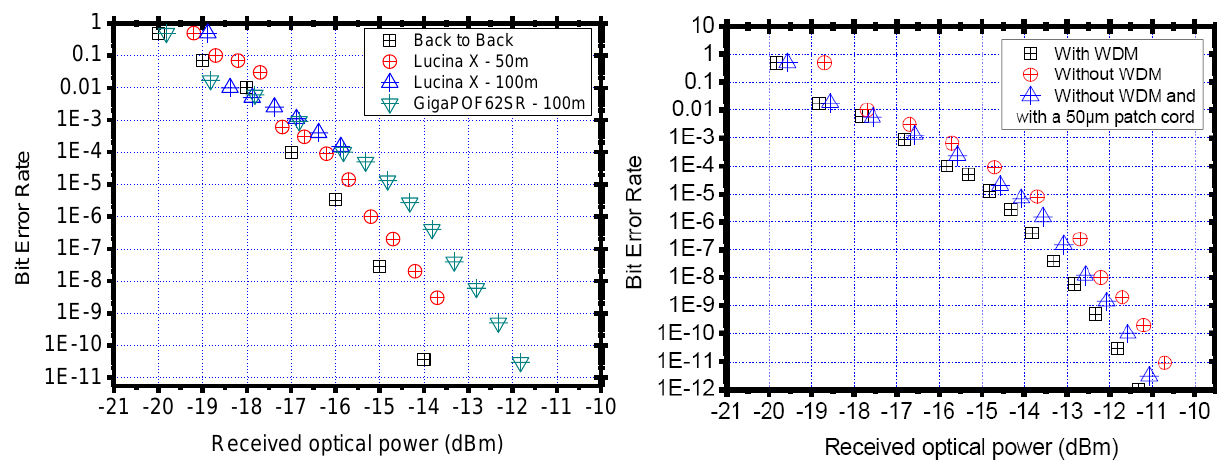
Figure 21. ( Left ) Evolution of the BER as a function of the received optical power for Lucina-X (50 m and 100 m), as compared to GigaPOF62-SR (100 m). The measurement is performed on the system including the WDM devices. ( Right ) Illustration of the penalties for the WDM devices used for the multi-services